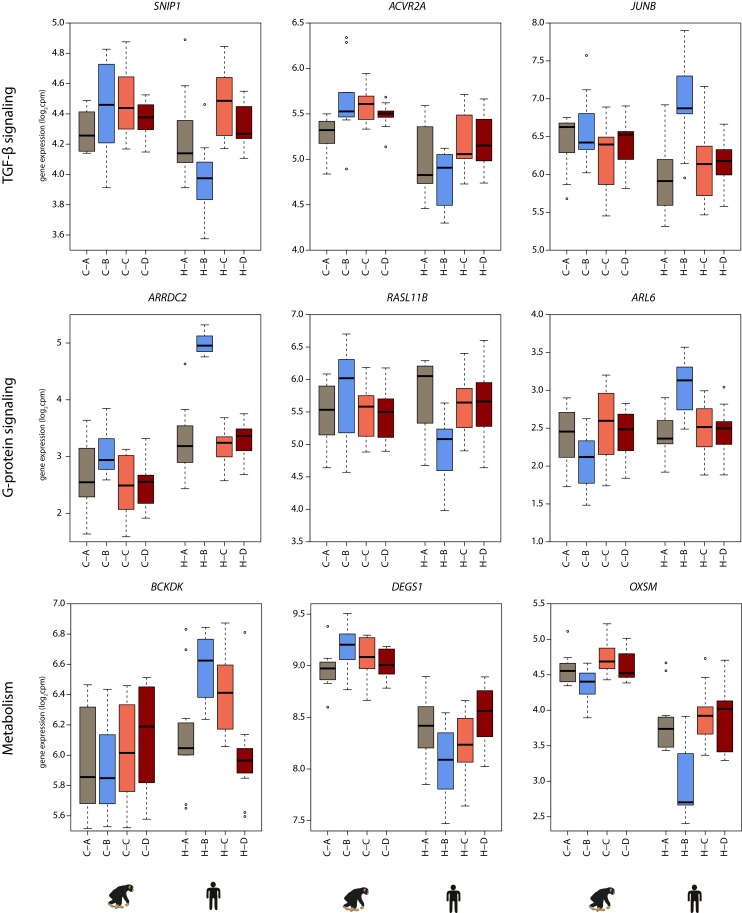
Genes responding in a species-specific manner have a variety of cellular functions.Examples of genes with a species-by-condition interaction that can be classified as having functions related to TGF-β signaling, G-protein signaling and metabolism. Gene expression values (log2cpm) in the baseline normoxic (A: brown), hypoxic (B: blue), short-term re-oxygenation (C: coral), and long-term re-oxygenation (D: dark red) conditions are shown for each species (C- chimpanzee; H- human).